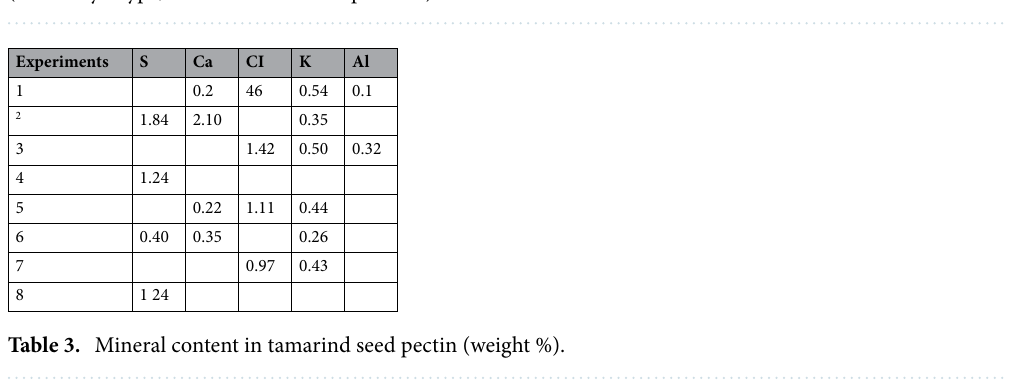
Figure 1. Pareto diagram for pectin extraction yield, ( a ) mango, ( b ) orange, ( c ) tamarind, and ( d ) tangerine (A = catalyst type; B = time and C = temperature).